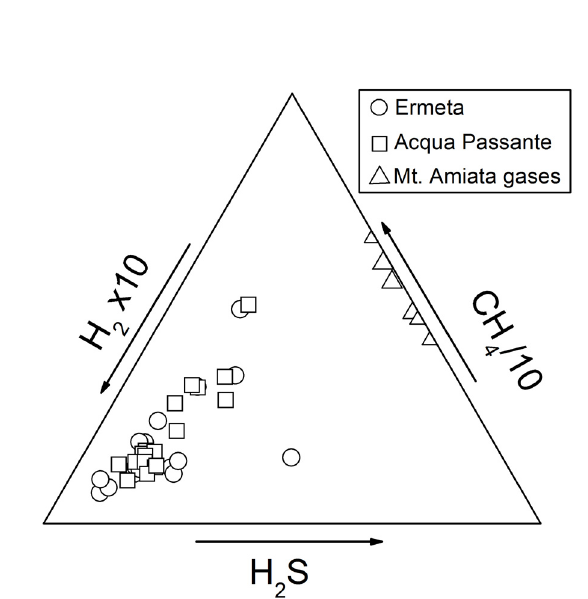
values obtained by applying the 2 (in mol m -2 day -1 ). 2